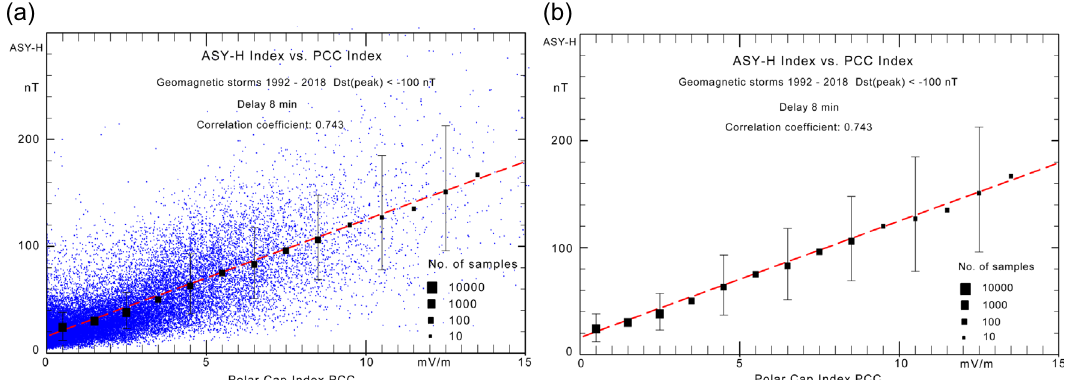
Fig. 9. Scatter plots of ASY-H against PCC index values. (a) Display of individual ASY-H-PCC samples. (b) Display without samples. The black squares indicate average values and number of 15-min samples within each unit interval in PCC, while the error bars at every other unit interval indicate standard deviation. The red dashed lines indicate least squares regression on the 15-min data samples (Eq. (7)). Note the good fi t to the interval-average squares.